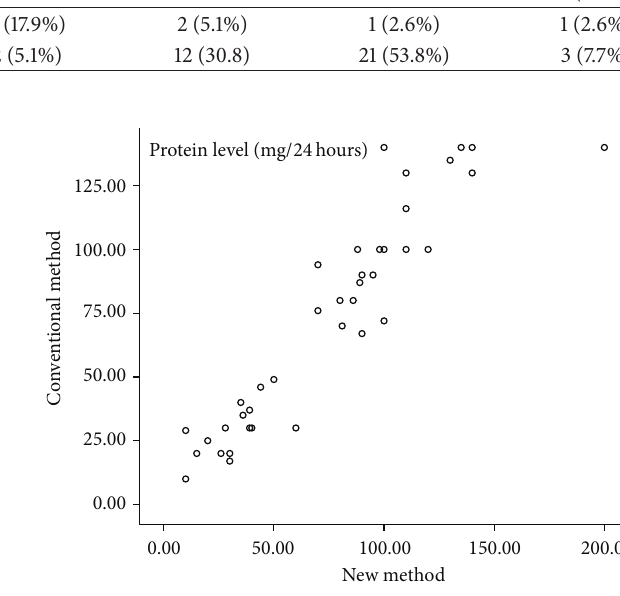
Figure 4: Bland-Altman plot: Relation between the new method and the conventional 24-hour urine creatinine. The horizontal lines show the limits of agreement of the differences between the two methods.